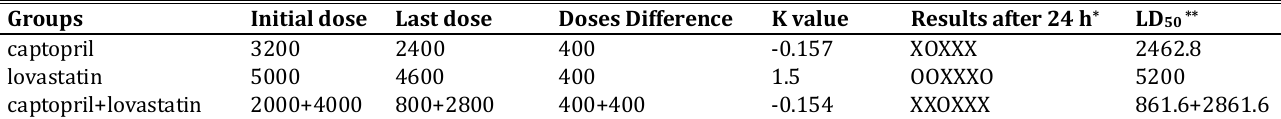
Figure 2. Isobolographic for interaction of acute toxicity between spironolactone and lovastatin BY applying Tallarida equation, the result was: Table 3. LD50 estimation for captopril, lovastatin and their interaction in study of chronic